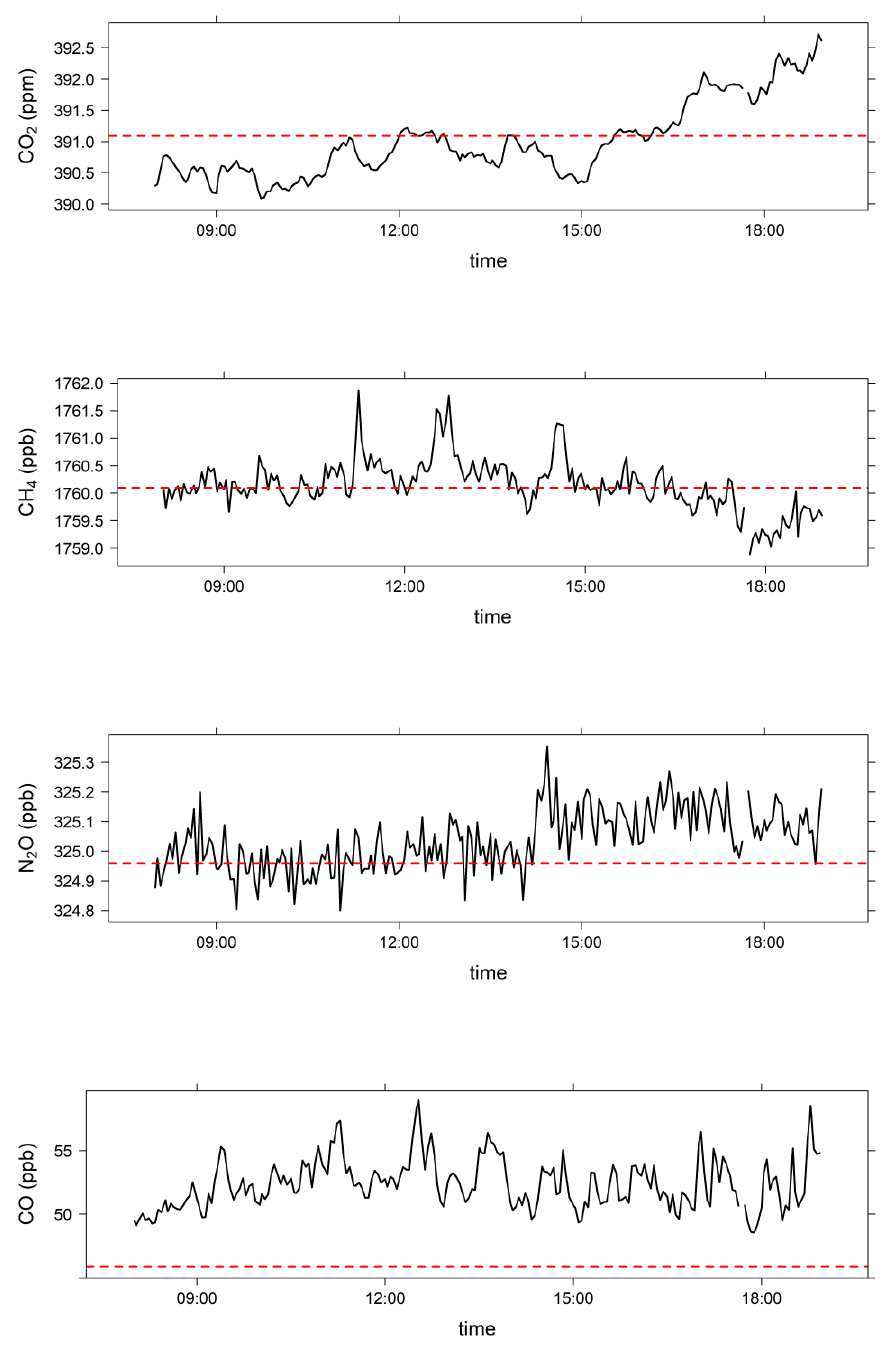
Figure A2. 3-minute timeseries of CO 2 , CH 4 , N 2 O and CO on 26 December 2012 between 08:00 and 18:59. The red dashed horizontal line is the Cape Grim baseline value for 26 December 2012.